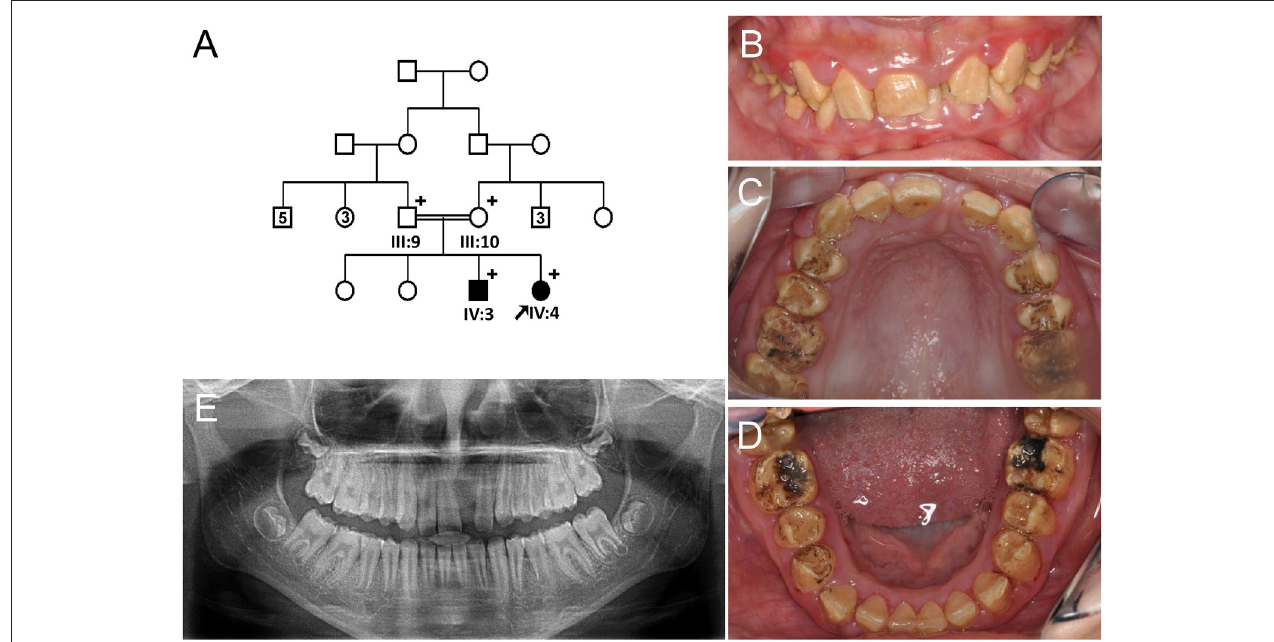
FIGURE 1 | Pedigree and clinical phenotype of the proband of Family 1. (A) Pedigree of family 1. (B) Frontal view of the proband (IV:4) at age 11. (C) Maxillary occlusal view. (D) Mandibular occlusal view. (E) Panoramic radiograph of the proband at age 11. Numbers in the subject symbol indicate the number of siblings. Plus symbols indicate individuals who participated in this